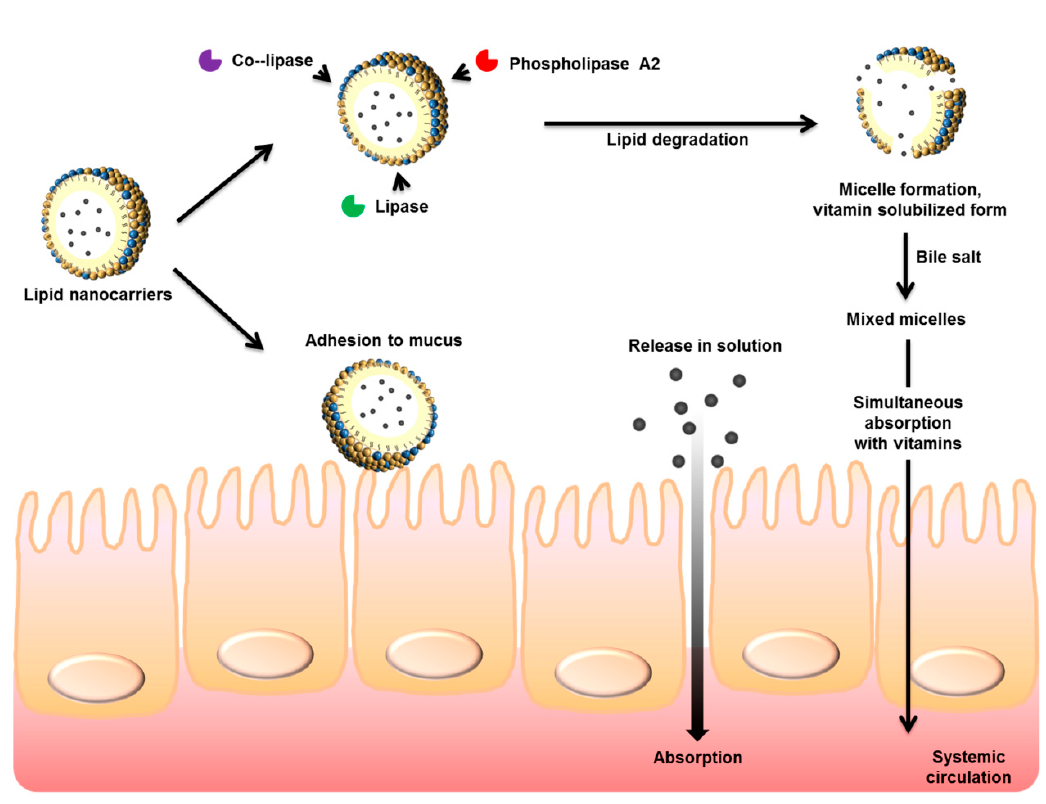
Figure 4. Possible pathways of gastrointestinal absorption of orally administered lipid nanoparticles.